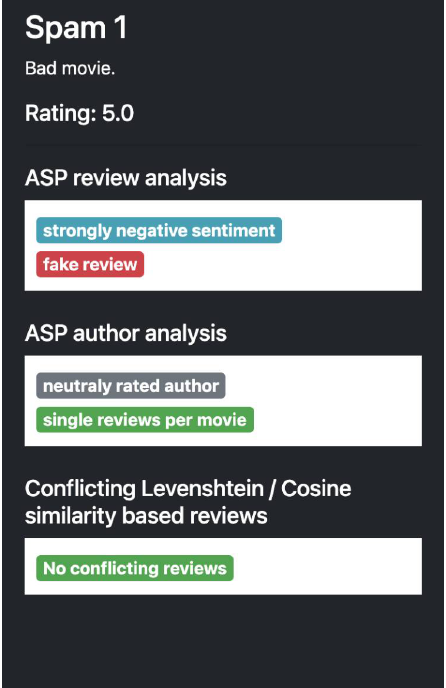
Figure 5. Spam review